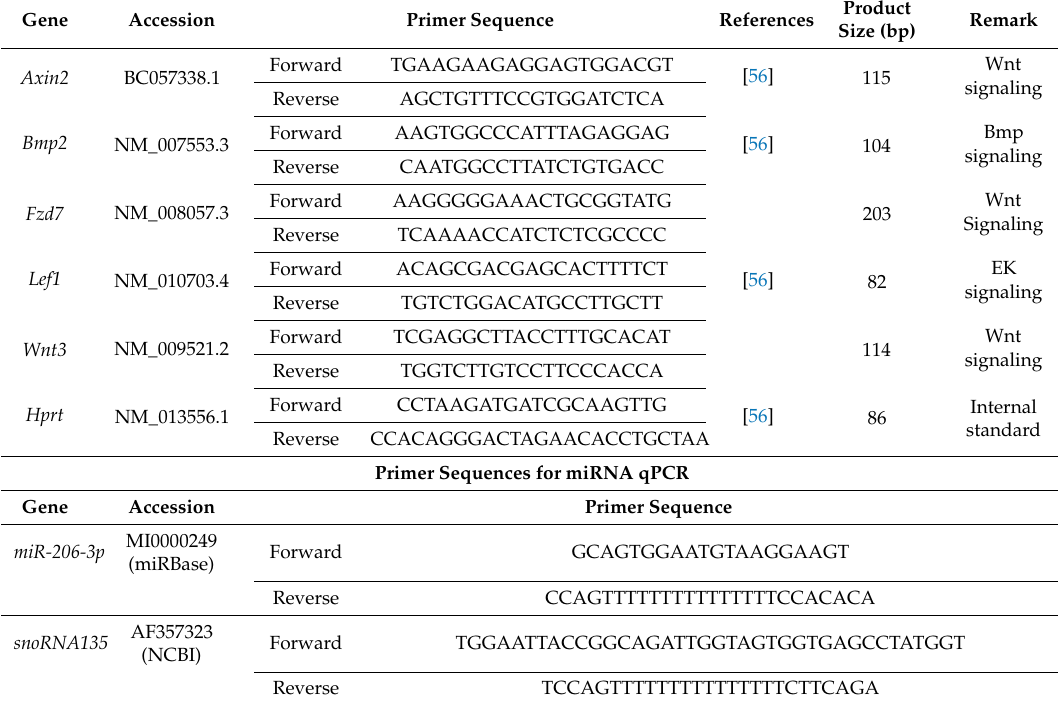
Table 1. Primer sequences for